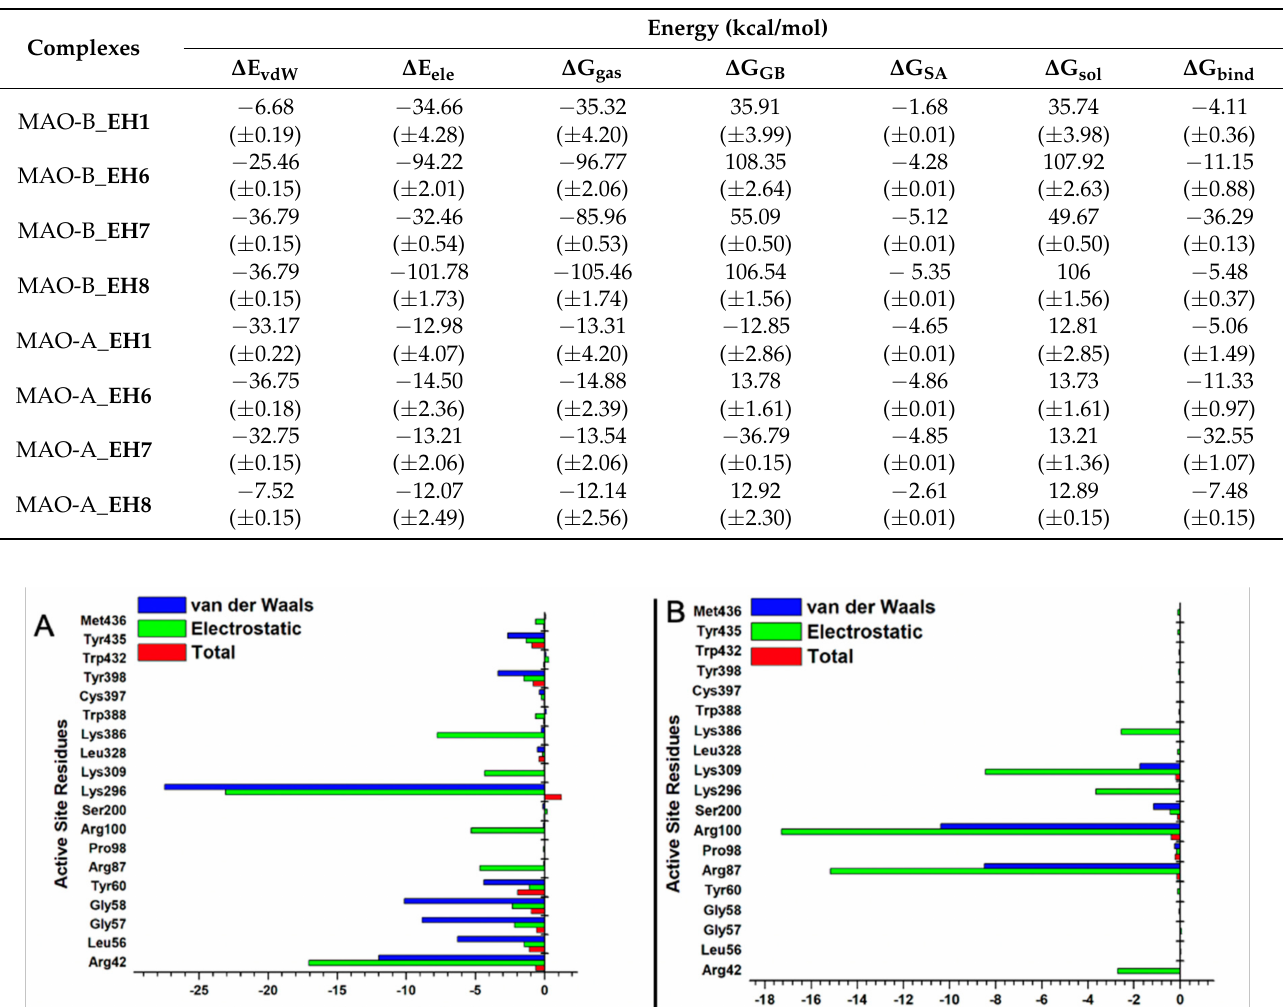
Table 4. The total free binding energy contributions of EH , EH6 , EH7 , and EH8 .